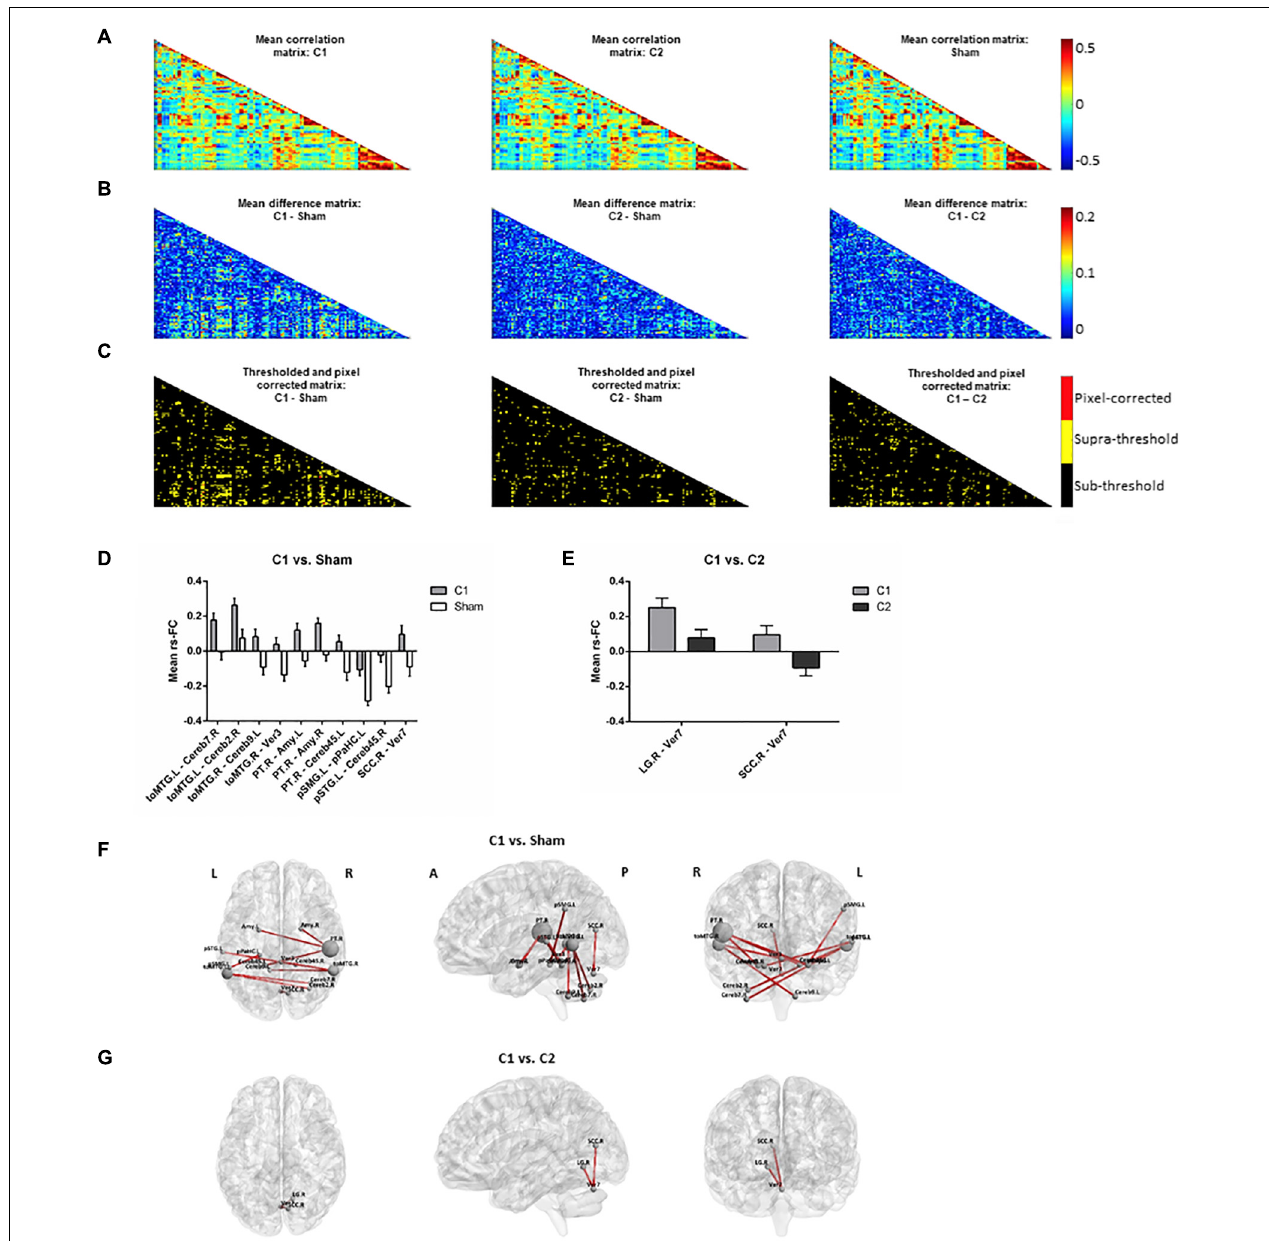
FIGURE 3 | Rs-fMRI analyses. (A) Mean correlation matrices for (left to right): C1, C2 and sham. (B) Mean difference matrices for (left to right): C1 – Sham, C2 – Sham, C1 – C2. (C) Thresholded and pixel-corrected matrices for (left to right): C1 – Sham, C2 – Sham, C1 – C2 (dark: sub-threshold; yellow: supra-threshold; red: pixel-corrected). Bar-plots showing the mean with standard error of the mean ( SEM ) of rs-FC comparing (D) C1 vs. Sham and (E) C1 vs. C2, computed for visually inspecting the group tendencies in each coupling. Representation of the significant connections for (F) C1 vs. Sham and (G) C1 vs. C2 on a standard map (left to right: axial, sagittal and coronal view). Note that in Panel (F) , selected main hubs (i.e., those ROIs entailing ≥ 2 significant rs-FC connections when comparing C1 vs. Sham) are displayed with a correspondingly larger size to emphasize them. C1, condition 1; C2, condition 2; toMTG, Middle temporal gyrus, temporo-occipital part; Cereb, Cerebellum; Ver, Vermis; PT, Planum temporale; Amy, Amygdala; pSMG, Supramarginal gyrus, posterior division; pPaHC, Parahippocampal gyrus, posterior division, pSTG, Superior temporal gyrus, posterior division; SCC, Supracalcarine cortex; LG, Lingual gyrus; L, left; R, right; A, anterior; P,